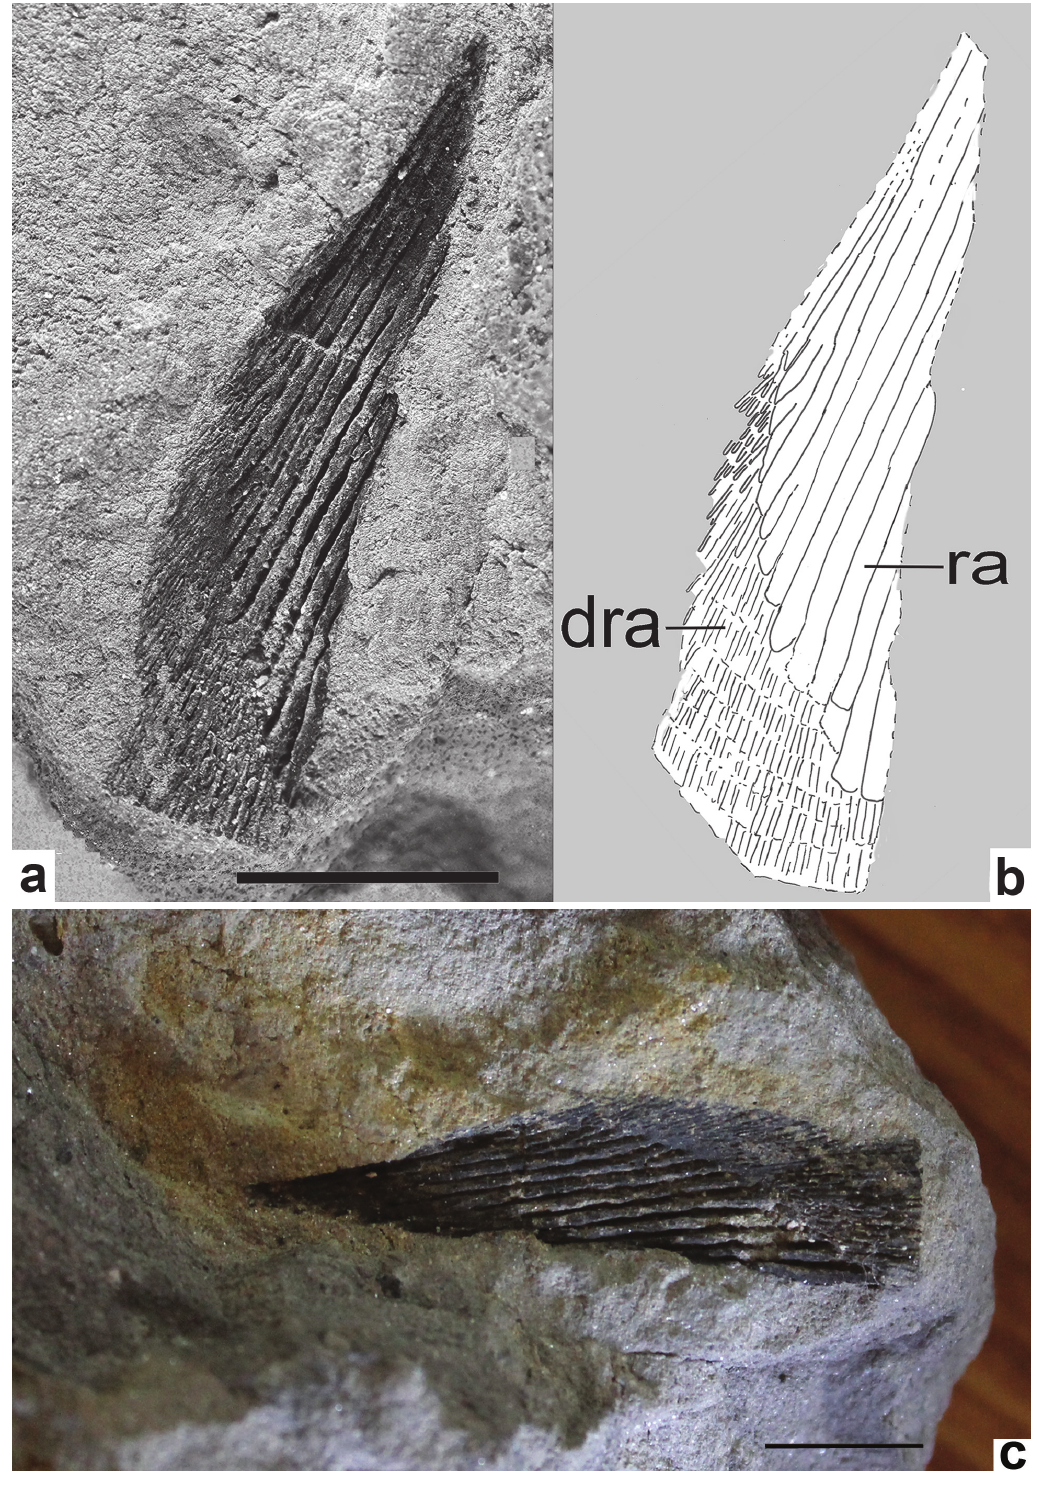
Figure 5 - UEPG DEGEo MPI9959. Partially preserved chondrichthyan fin. a . Photograph of the specimen; b . Interpretative drawing depicting proximal (ra) and distal radials (dra); c. Photograph showing the natural colours of this specimen and the rock matrix. Scale= 10mm (see the colors in the online